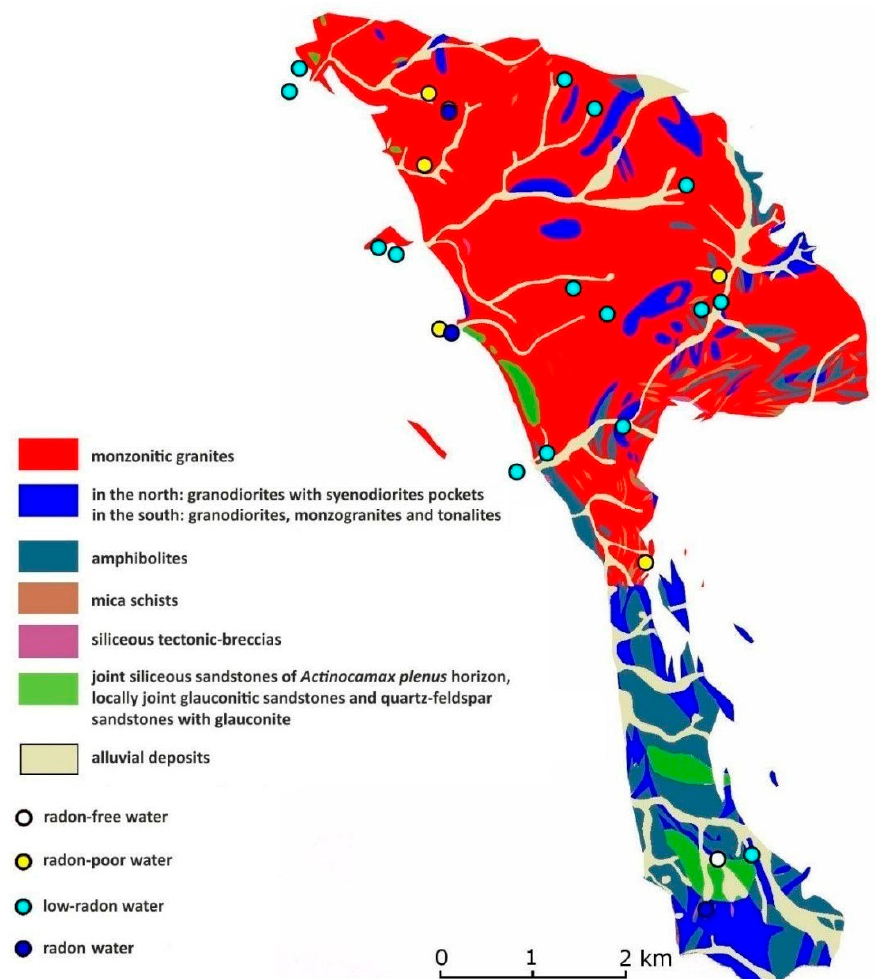
Figure 5. The Tatra granitoids. Groundwater sampling sites plotted together with the types of collected water by 222 Rn content according to Przylibski’s classification [2].